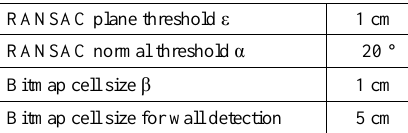
Table 1. Parameters used for indoor modelling of both data sets (‘Classroom’ and ‘Office’).